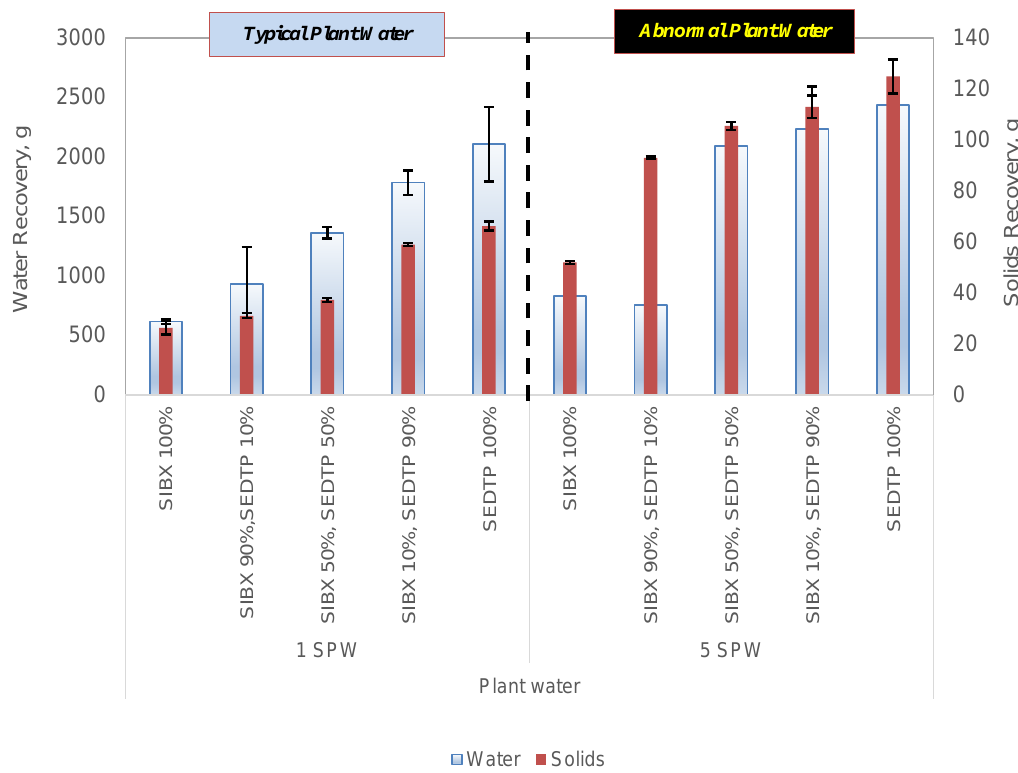
Figure 2. Water and solids recovery for all SIBX / SEDTP mixtures and ionic strengths of process water.